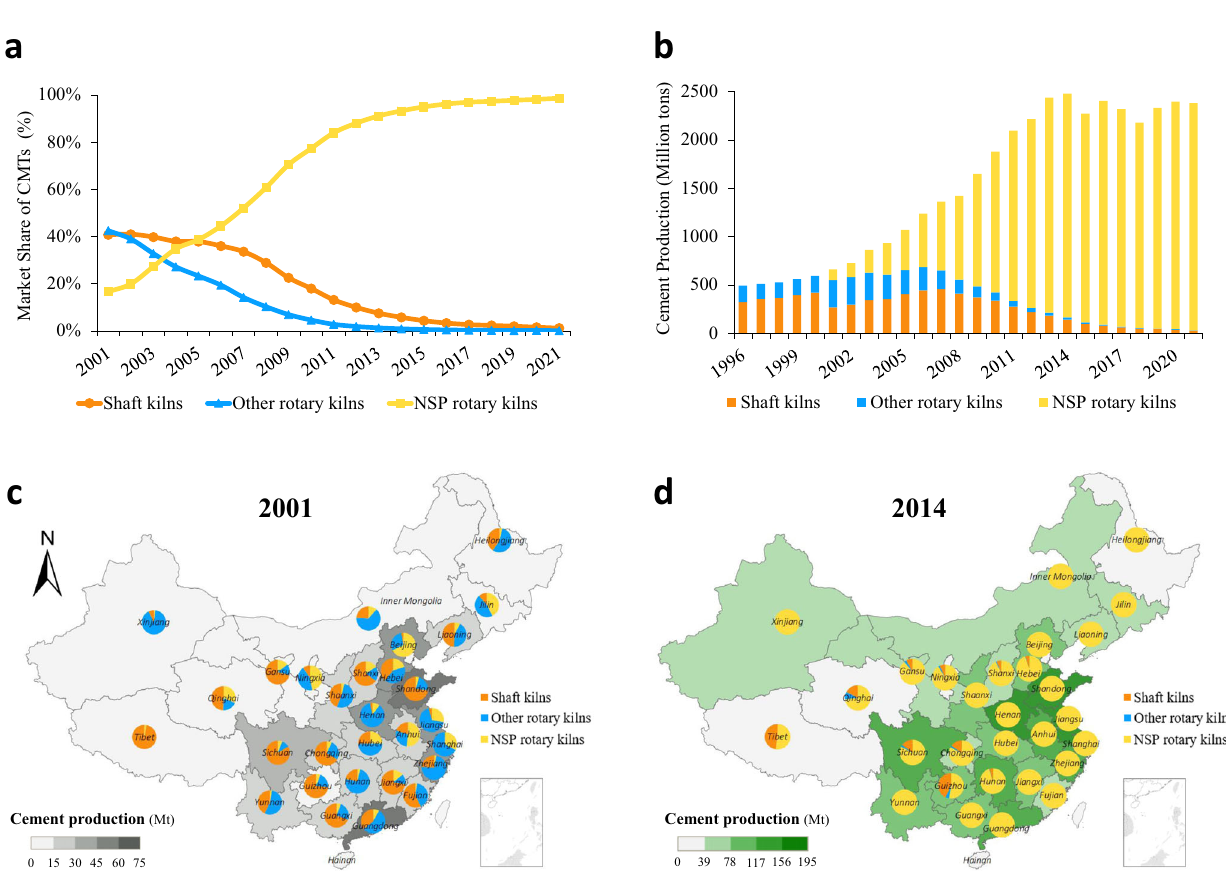
Fig. 1 The structure of and regional disparities in the cement industry in China. a illustrates the evolution of China ’ s cement manufacturing technology. b shows the cement production from different CMTs from 1996 to 2021. c , d compare the regional disparities in China ’ s cement industry in 2001 and 2014. The cement manufacturing technologies of Hainan Province, Tianjin Municipality, and Taiwan Province are not included due to data availability. Data on cement production by province are collected from China Cement Almanac 63 , Almanac of China Building Materials Industry 64 , and National Burau of Statistics in China 65